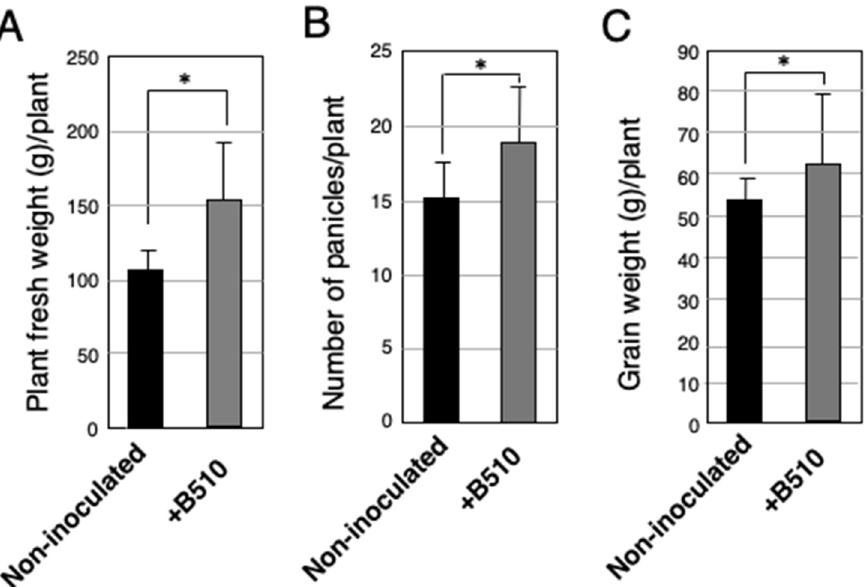
Figure 4. The effect of B510 inoculation on rice growth managed under field conditions in Nsawam, Ghana. A field test was performed in Ohayo-farm at Nsawam using cv. Ex-baika. Plants were grown in a nursery field and seedlings were inoculated with B510. After 2 dpi, the plants were transferred to the paddy field. Grain yield was measured after 2 months. Growth characteristics assessed were fresh weight of the upper grown parts ( A ), number of panicles ( B ), and grain weight per plant ( C ). Bar colors: non-inoculated control (black) and inoculated with B510 (gray). Values presented are the average ± SD from 10 plants each 7 plots. Statistical analysis was performed, the asterisk indicates the significant differences between treatments (Unpaired Student’s test, p < 0.05, n =